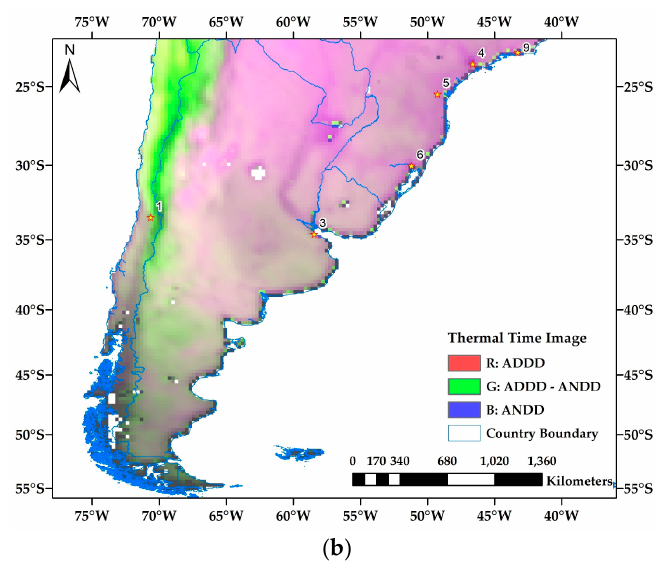
Figure 4. False color composite of thermal time metrics for tropical America ( a ) and the Southern Cone ( b ). Labels show urban identification numbers as presented in Table S1.